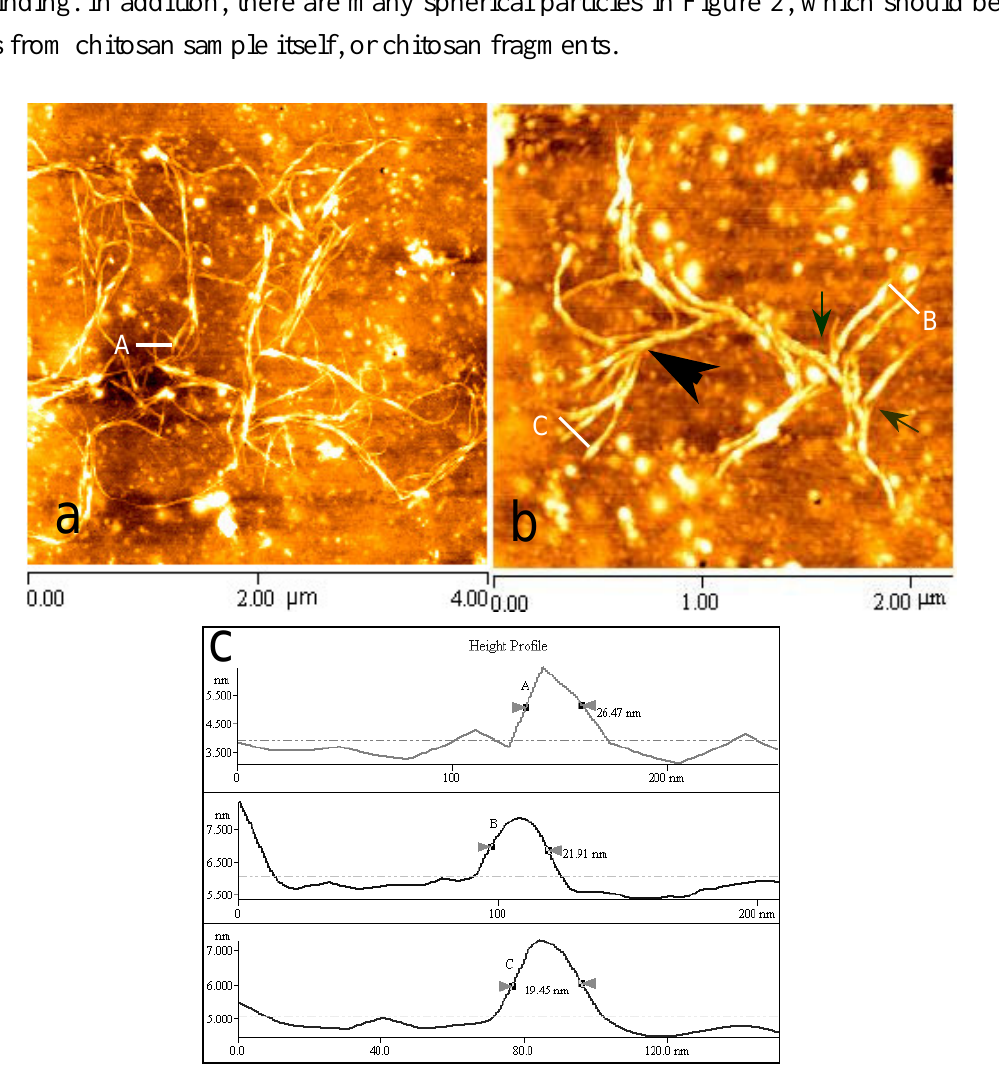
nm, 1.694 nm and 2.156